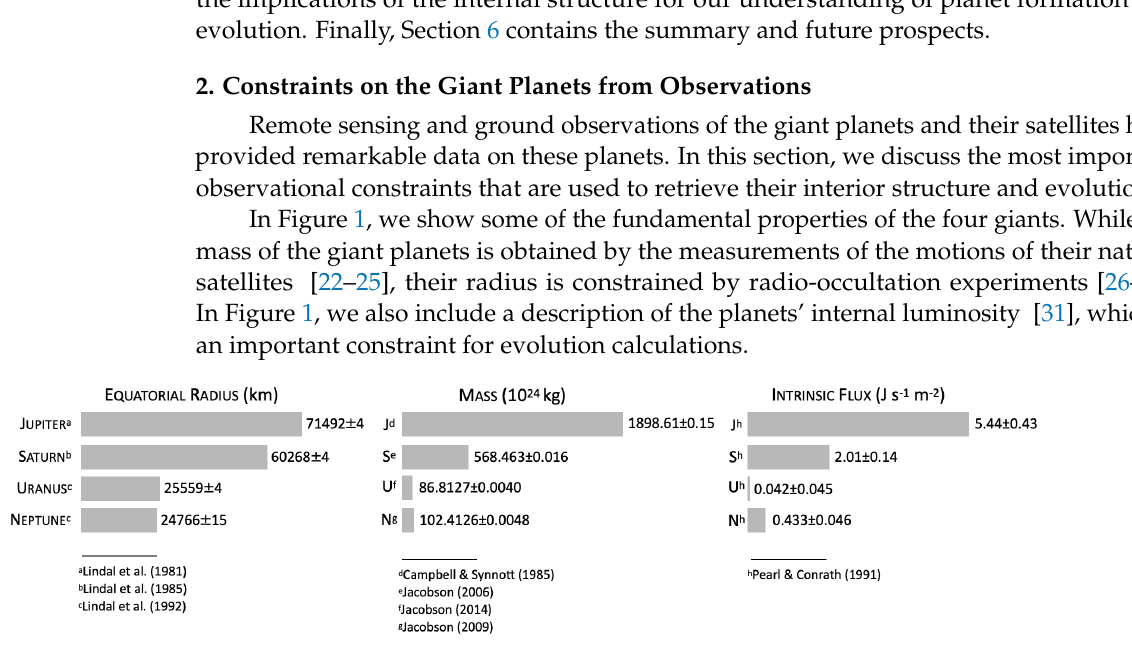
Figure 1. Fundamental properties of the four giants of the solar system